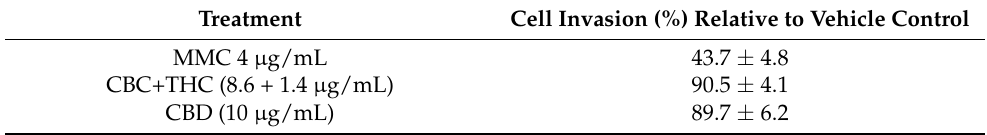
Table 1. The effect of the cannabinoid compounds on cell invasion.